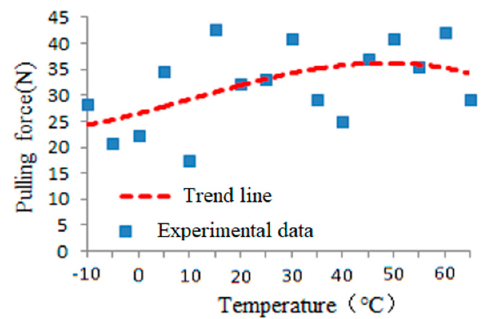
Figure 13. Two-point tensile ultimate force temperature curve.